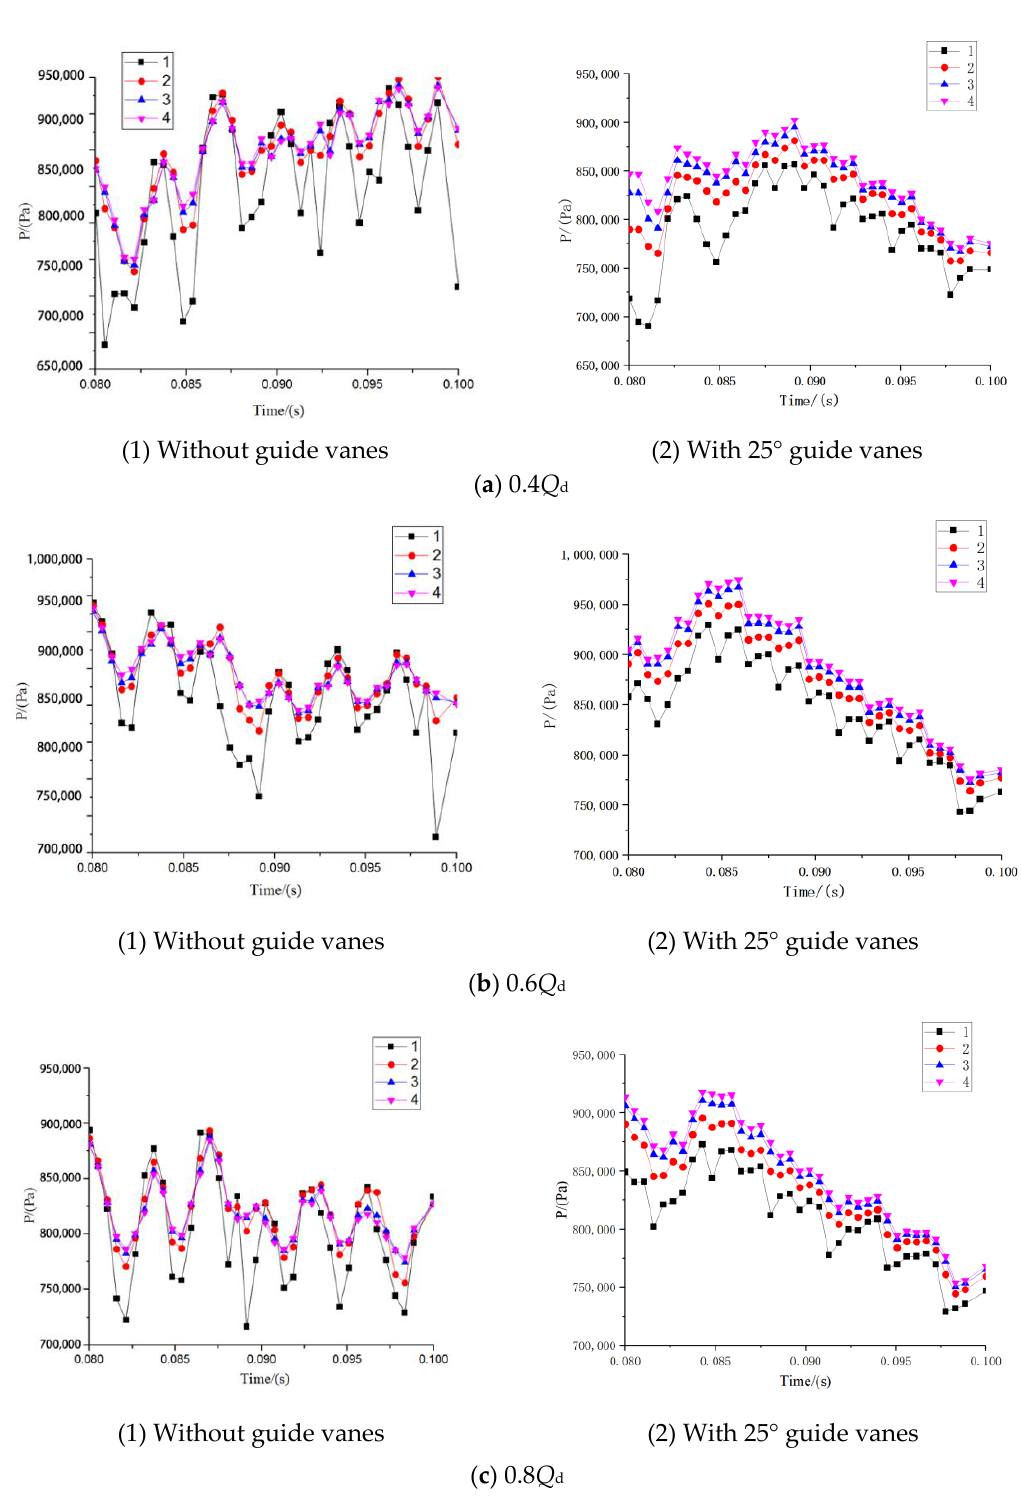
Figure 12. Static pressure distribution of section VI for different flow rates: ( a ) 0.4 Q d , ( b ) 0.6 Q d , ( c ) 0.8 Q d.